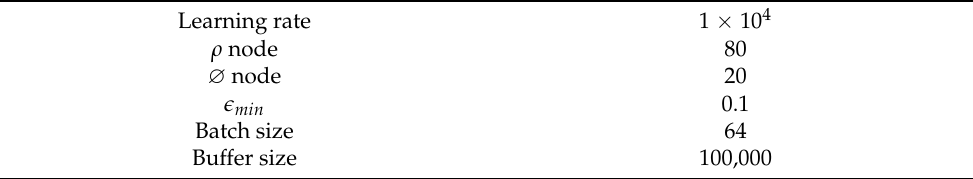
Table A1. DeepSet-Q